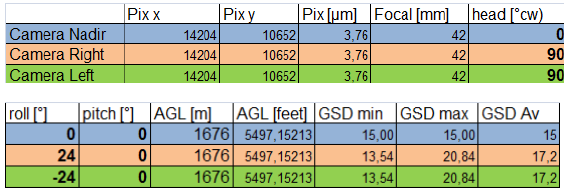
Figure 5. Calculation of the flight altitude, GSD range and other parameters